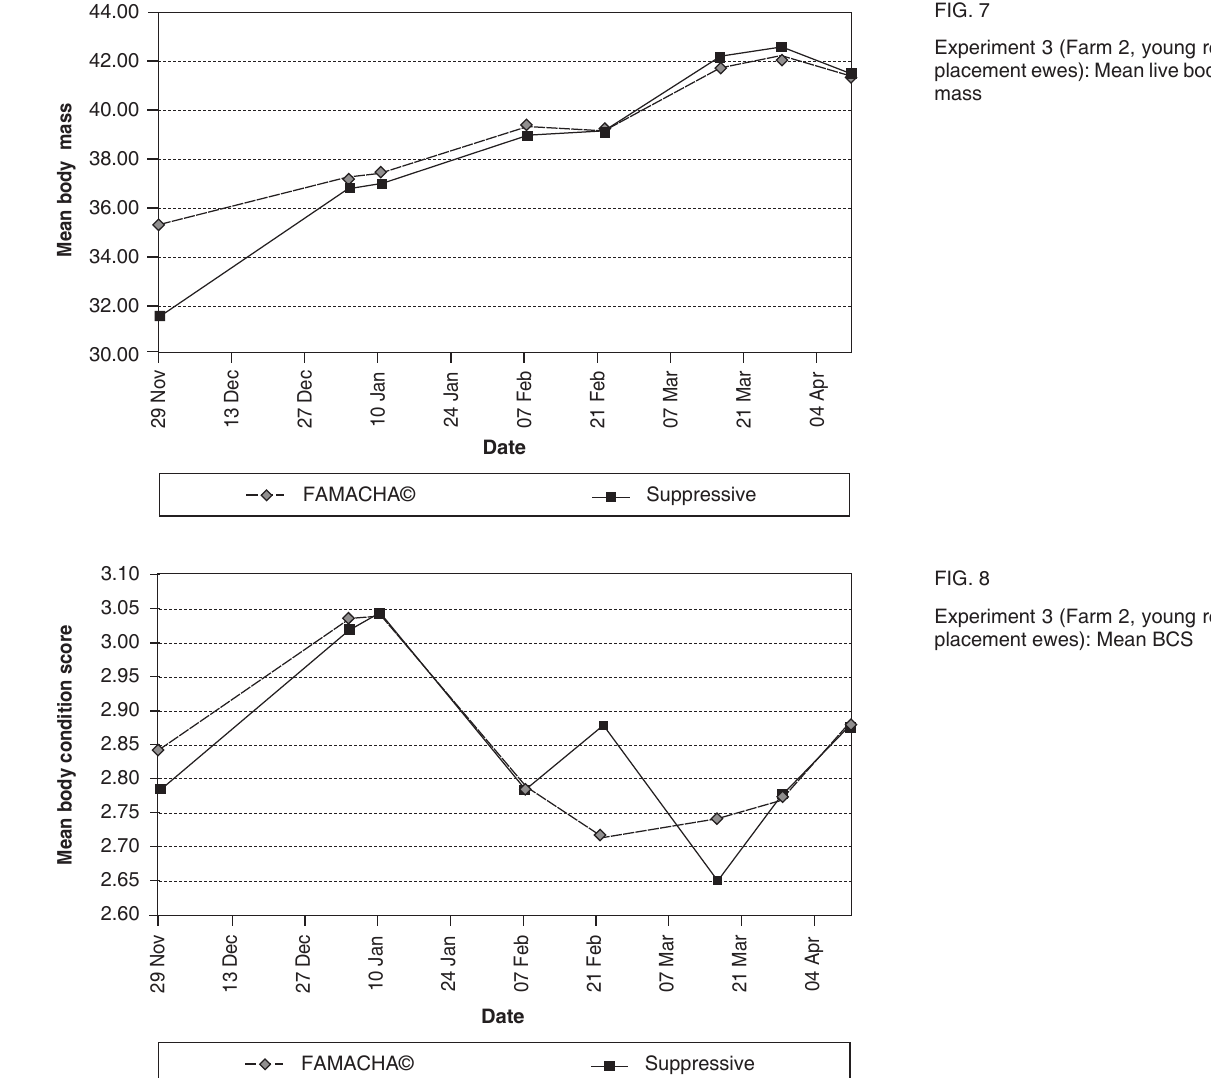
Experiment 3 (Farm 2, young re- placement ewes): Mean live body mass